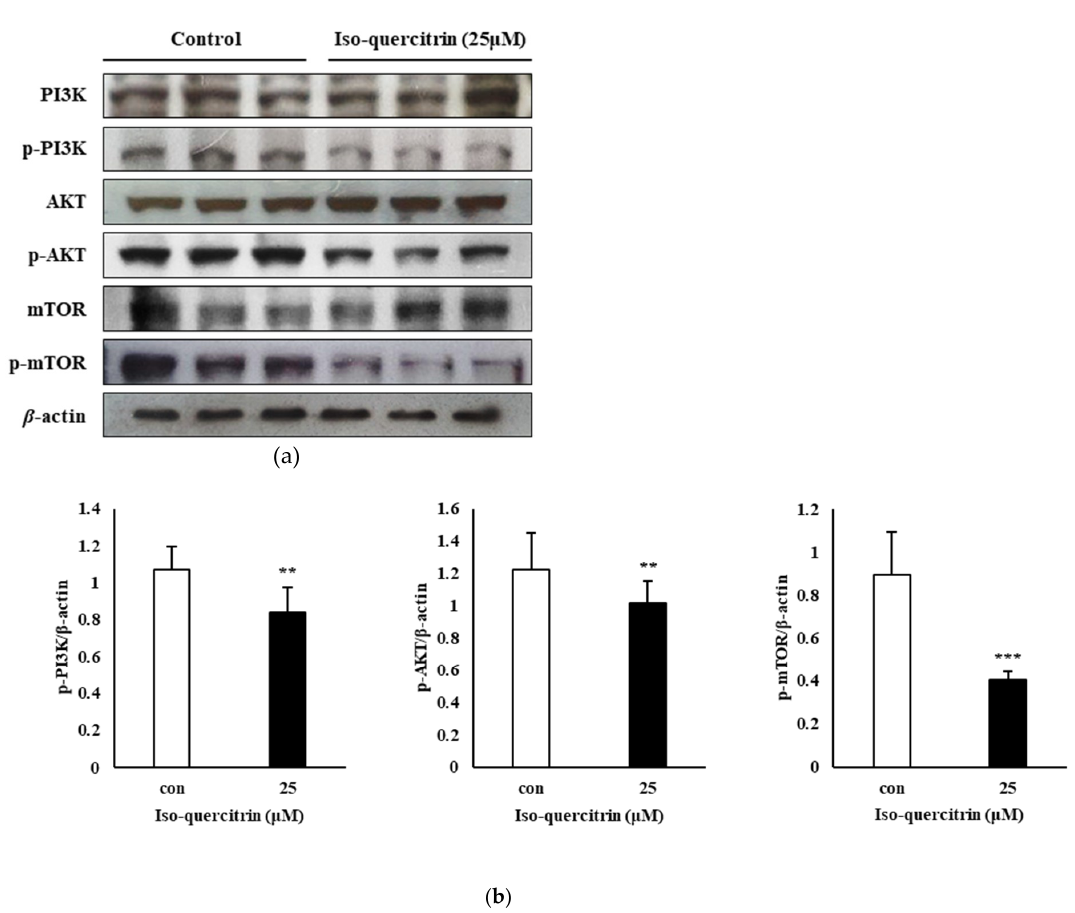
Figure 7. Isoquercitrin downregulates the PI3K/AKT/mTOR signaling pathway. ( a ) SK-MEL-2 cells were cultured in RPMI medium for 24 h and treated with 25 μM of isoquercitrin. Effect of IQ on the expression of phosphorylated PI3K, AKT, and mTOR in SK-MEL-2 cells was evaluated through the western blot analysis. ( b ) Results were quantified using the ImageJ software program. Results are expressed as a percentage. Data values are expressed as mean ± SD of triplicate determinations.